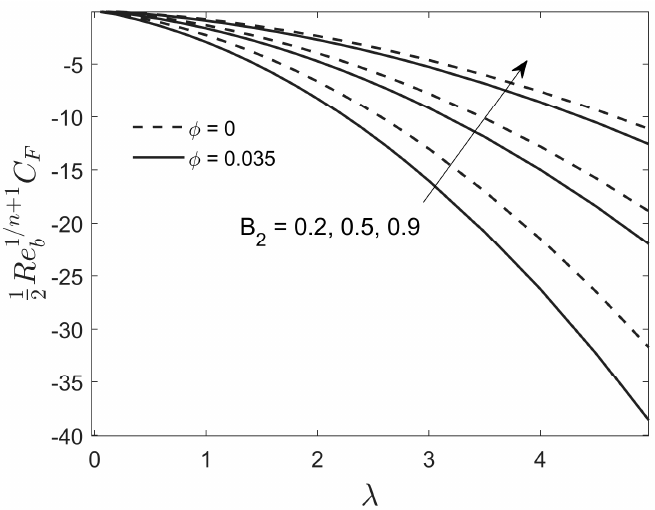
Figure 16. Effect of the slip on the skin friction coefficient against stretching/shrinking.